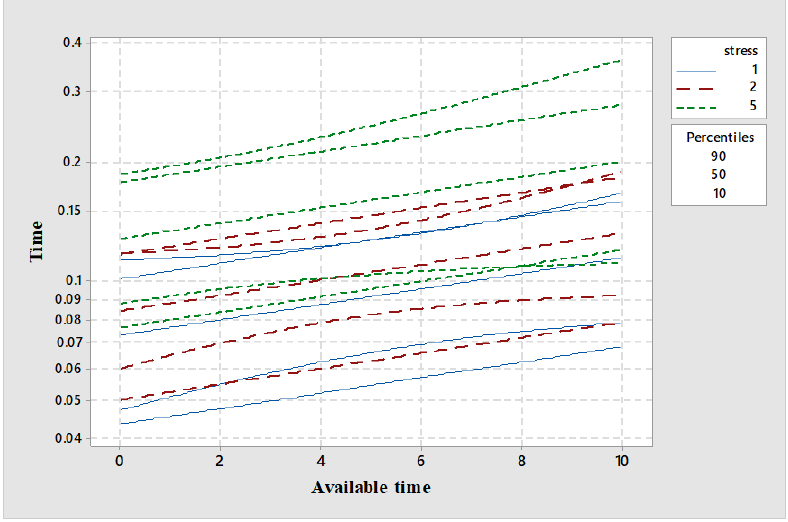
Fig. 4. The relation between fatigue and available time in different time value.